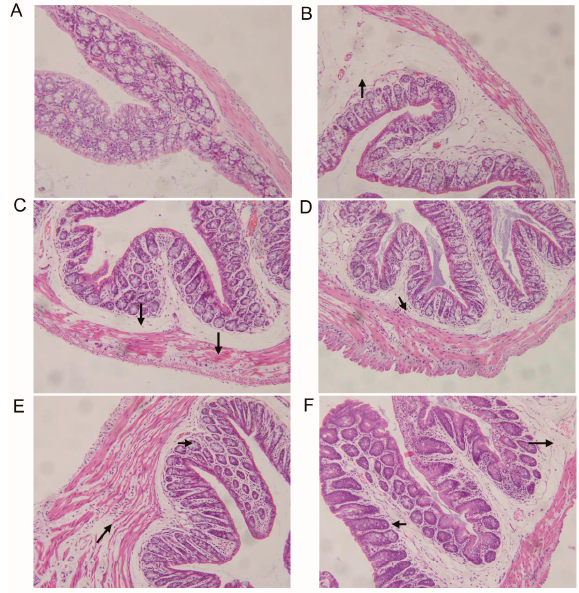
Figure 5. Vaccine immunization impacts intestinal histopathology after challenge. In comparison with healthy C57BL / 6 mice ( A ), nonimmunized C57BL / 6 mice challenged with toxins ( B ) displayed sporadic large sites of inflammation. The mice immunized with 1 µ g RBD-TcdA / B ( C ) or 10 µ g RBD-TcdA / B ( D ) and challenged with 1 MLD crude toxins displayed sporadic small sites of inflammation. The mice immunized with 1 µ g RBD-TcdA / B ( E ) or 10 µ g RBD-TcdA / B ( F ) and challenged with 2 MLD crude toxins displayed bigger sites of inflammation than mice challenged with 1 MLD. Similar results were observed in two independent